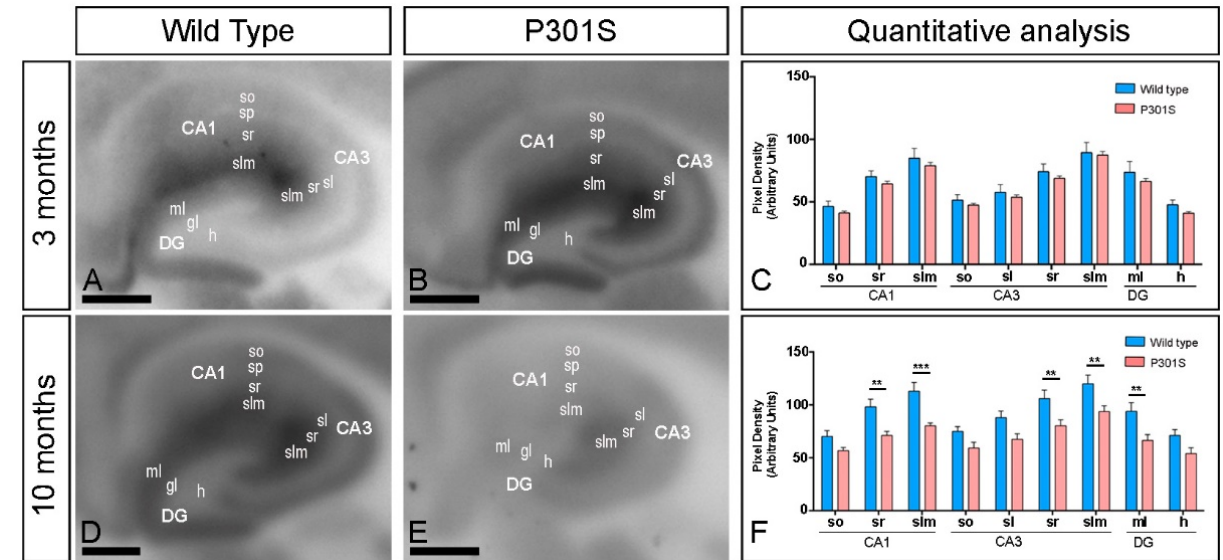
Figure 2. Hippocampal expression of GIRK2 in the hippocampus of P301S mice. ( A – F ) The expression of the GIRK2 protein was visualised in histoblots of horizontal brain sections at 3 and 10 months of age in wild type and P301S mice using an affinity-purified anti-GIRK2 antibody. GIRK2 expression in different hippocampal subfields and dendritic layers was determined by densitometric analysis of the scanned histoblots (panels C and F). GIRK2 expression in the CA1 region was strong in the stratum lacunosum–moleculare (slm) and distal half of the stratum radiatum (sr) and moderate in the proximal half of the stratum radiatum and the stratum oriens (so). In the CA3 region, expression for GIRK2 was strong in the strata lucidum (sl), radiatum (sr), and lacunosum–moleculare (slm), and moderate in the stratum oriens (so). In the DG, GIRK2 expression was strong in the molecular layer (ml) and weak in the hilus (h). Densitometric analysis showed no differences in GIRK2 expression in between wild-type and P301S mice of 3 months, but significant reduction in some dendritic layers at 10 months (Multiple t-tests and Holm-Sidack method, ** p < 0.01; *** p < 0.001). Error bars indicate SEM. Abbreviations : CA1 region of the hippocampus; CA3, CA3 region of the hippocampus; DG, dentate gyrus; so, stratum oriens ; sp, stratum pyramidale ; sr, stratum radiatum ; slm, stratum lacunosum-moleculare ; ml, molecular layer; gl, granule cell layer; h, hilus. Scale bars: 0.05